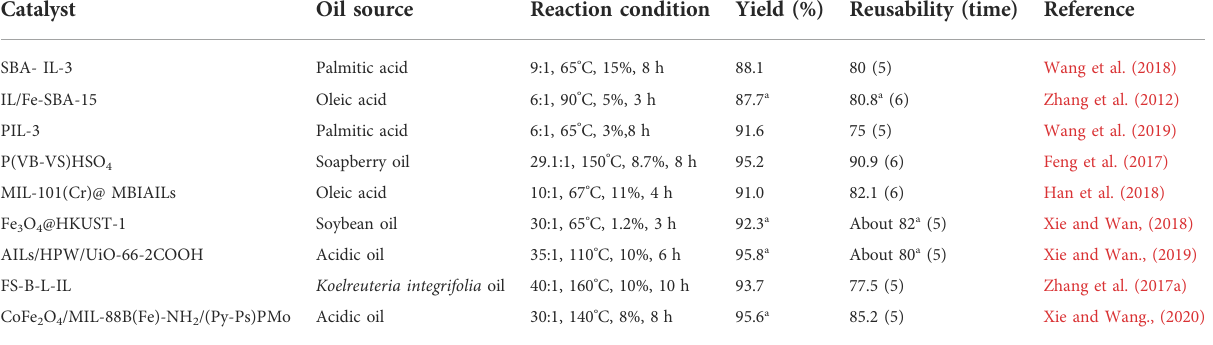
TABLE 1 Summary of carbon-supported metal oxides for biodiesel production.